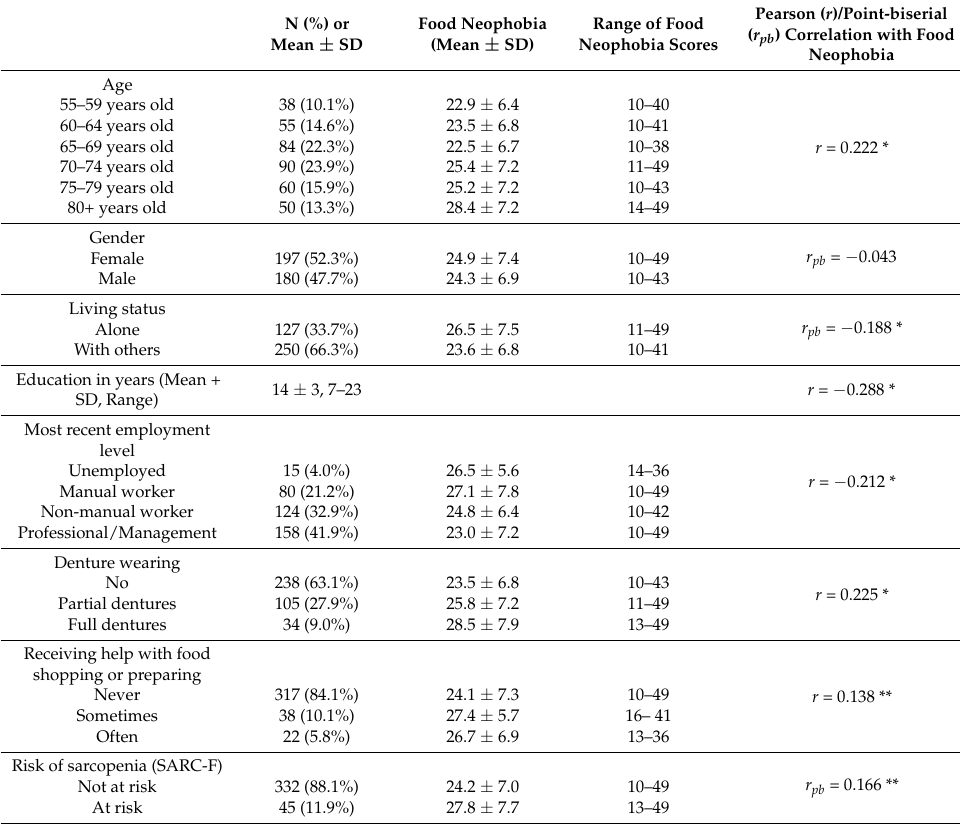
Table 1. Participant characteristics ( N =